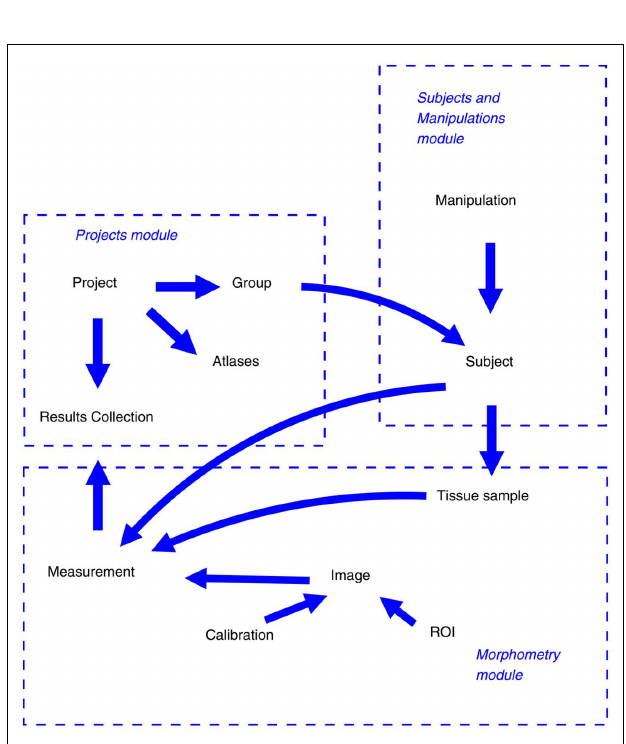
are handled by the communication layer, which is implemented in PHP.The data storage back-end is based on the relational database model of MySQL. (B) User interfaces of the ImageJ plugins: main form for data upload (top) and login form (bottom).The SQL-plugin accesses directly the MySQL server.